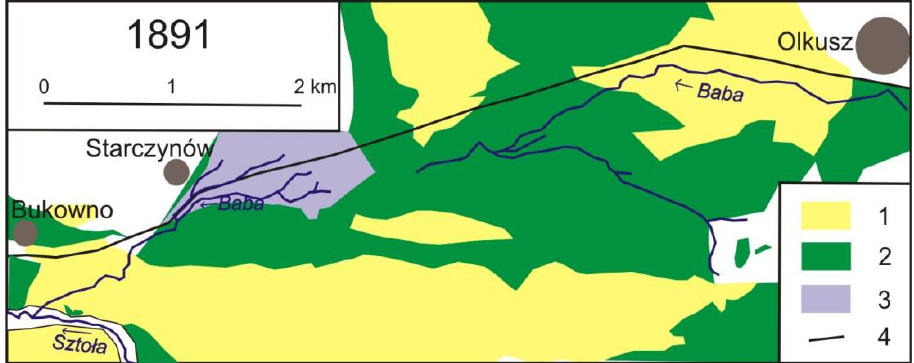
Fig. 5. Area of Starczynów „Desert” in 1891(on the base of Płastowaja karta polskowo kamiennougolowo basiejna made by Gatowski and Łempicki)